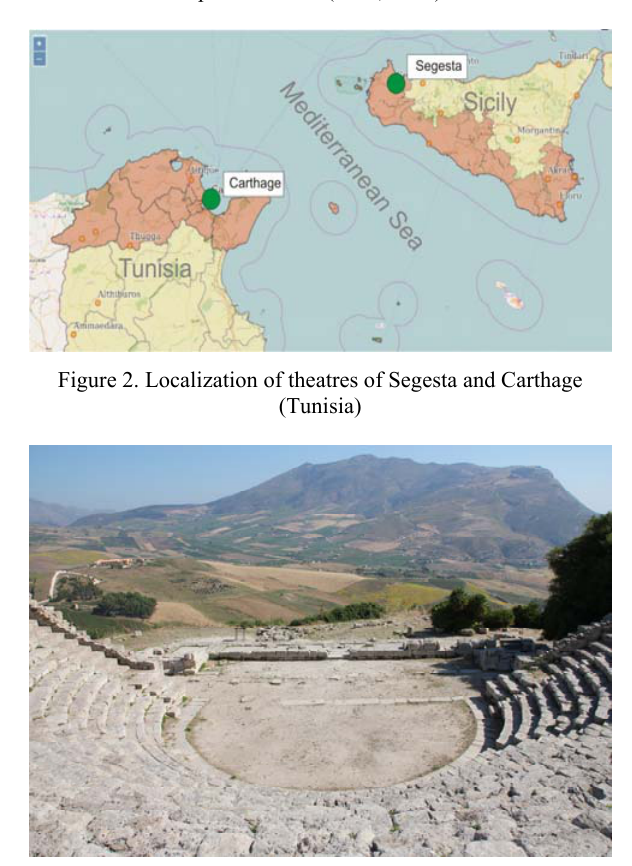
Figure 3. The Theatre of Segesta (real view)